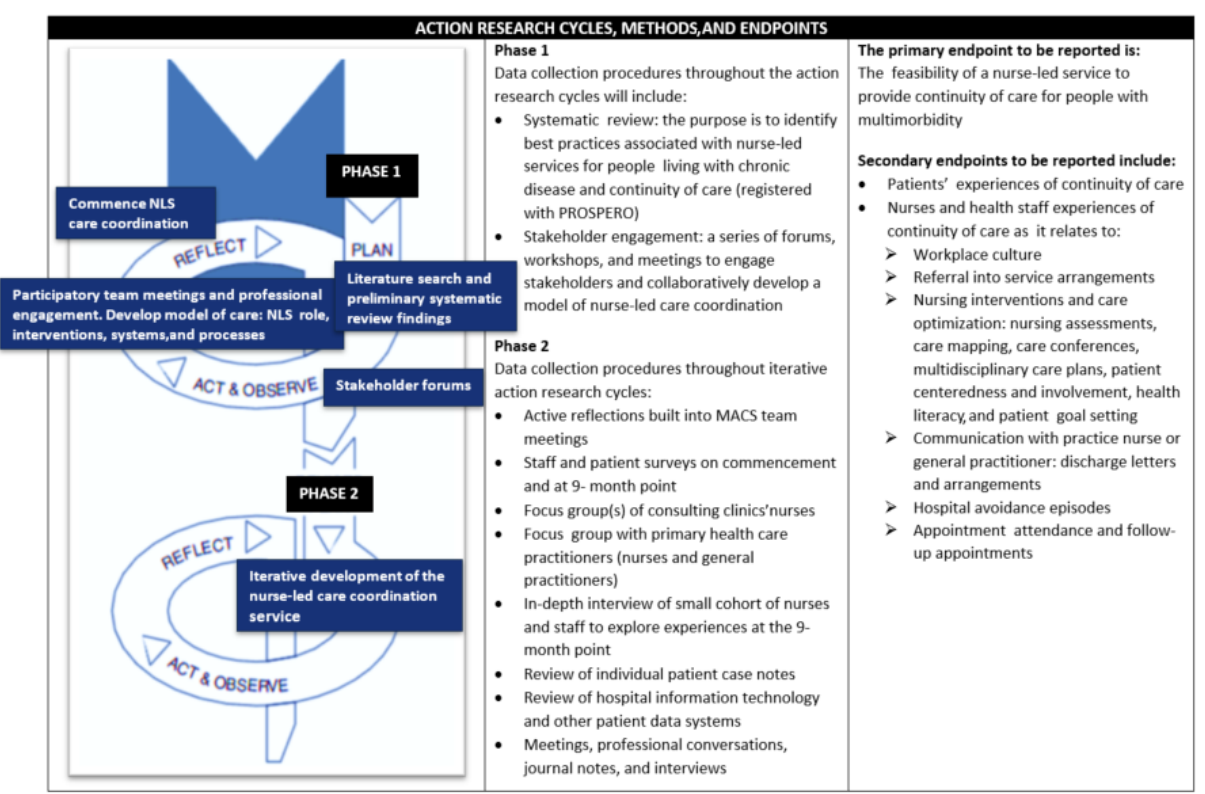
Figure 1. Design of the Multimorbidity Nursing Model of Care study. MACS: Multidisciplinary Ambulatory Consulting Service; NLS: nurse-led services; PROSEPERO: international prospective register of systematic